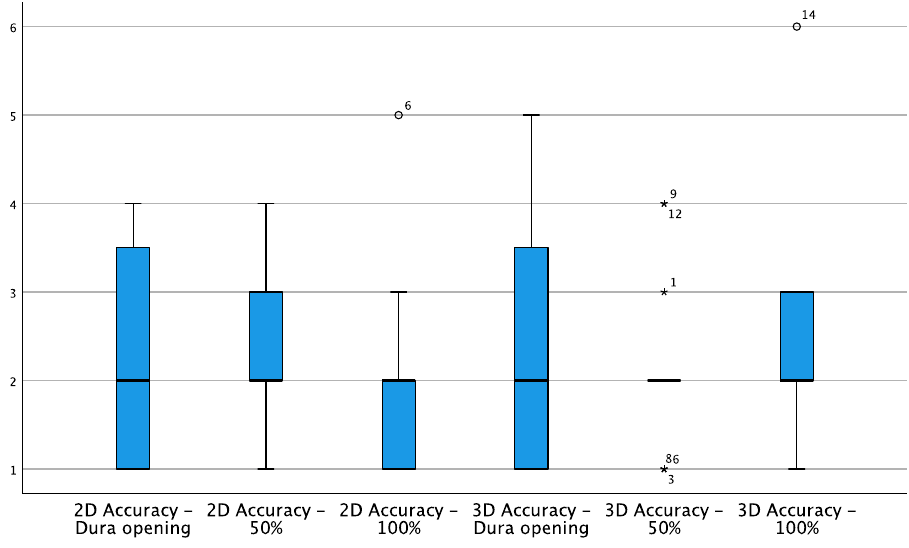
Figure 6. Box plot showing 2D and 3D accuracy variations during different stages of resection. White circles = low potential outlier (more than 1.5 inter-quartile range at most 3 inter-quartile range.. * = high potential outliers of more than 3 inter-quartile